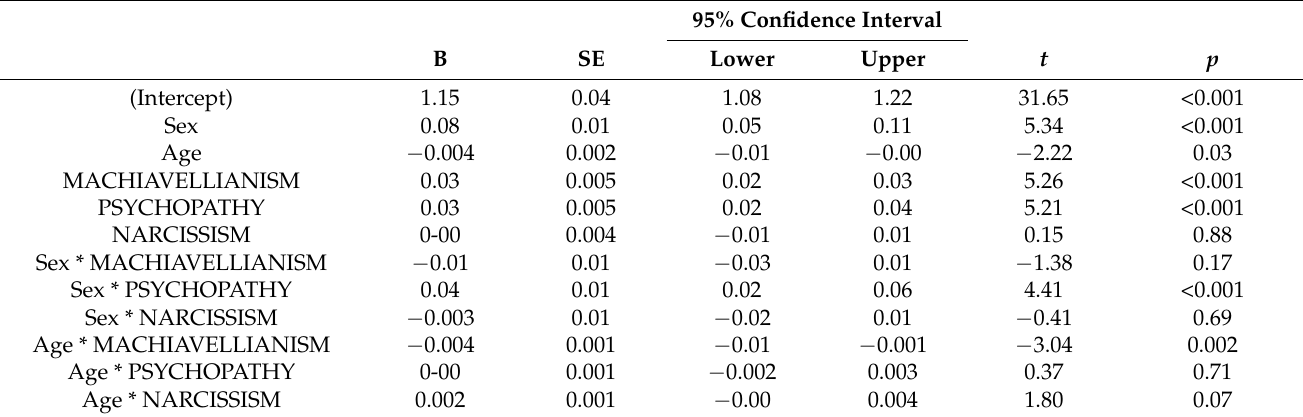
Table 11. Sexting under pressure: parameter estimates of fixed effects.